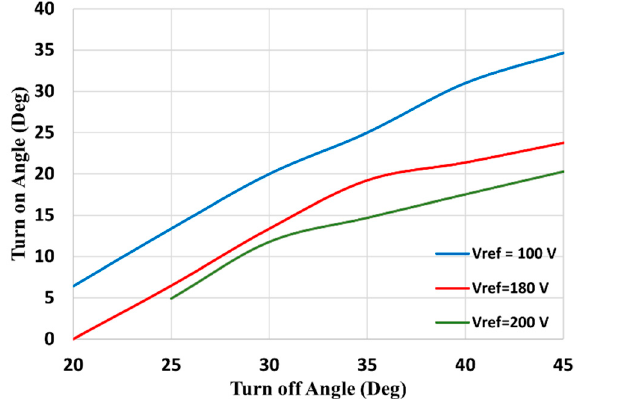
Figure 11. The effect of the initial turn-off angle on ( a ) the generated turn-on angle and ( b ) the max- imum generated current at different reference output voltages.